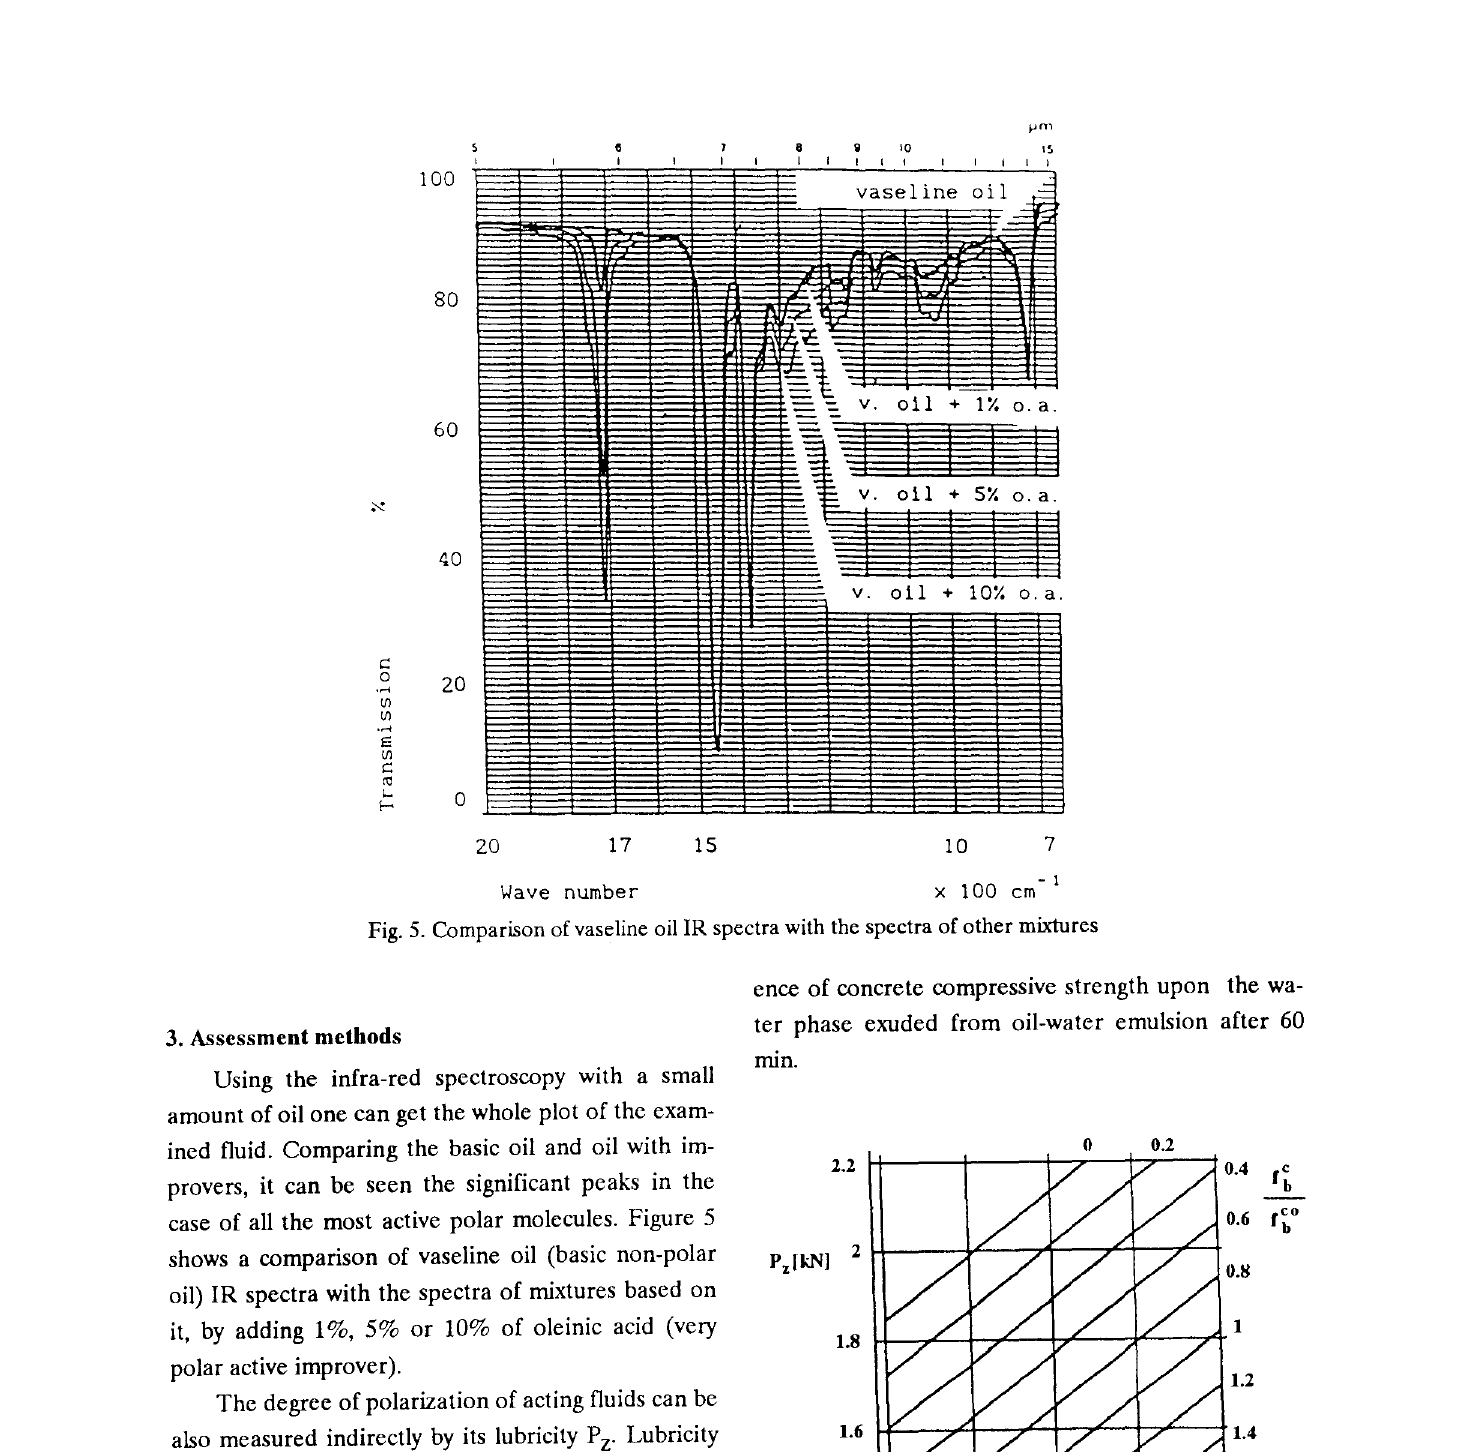
Fig. 6. Lubricity method chart for concrete